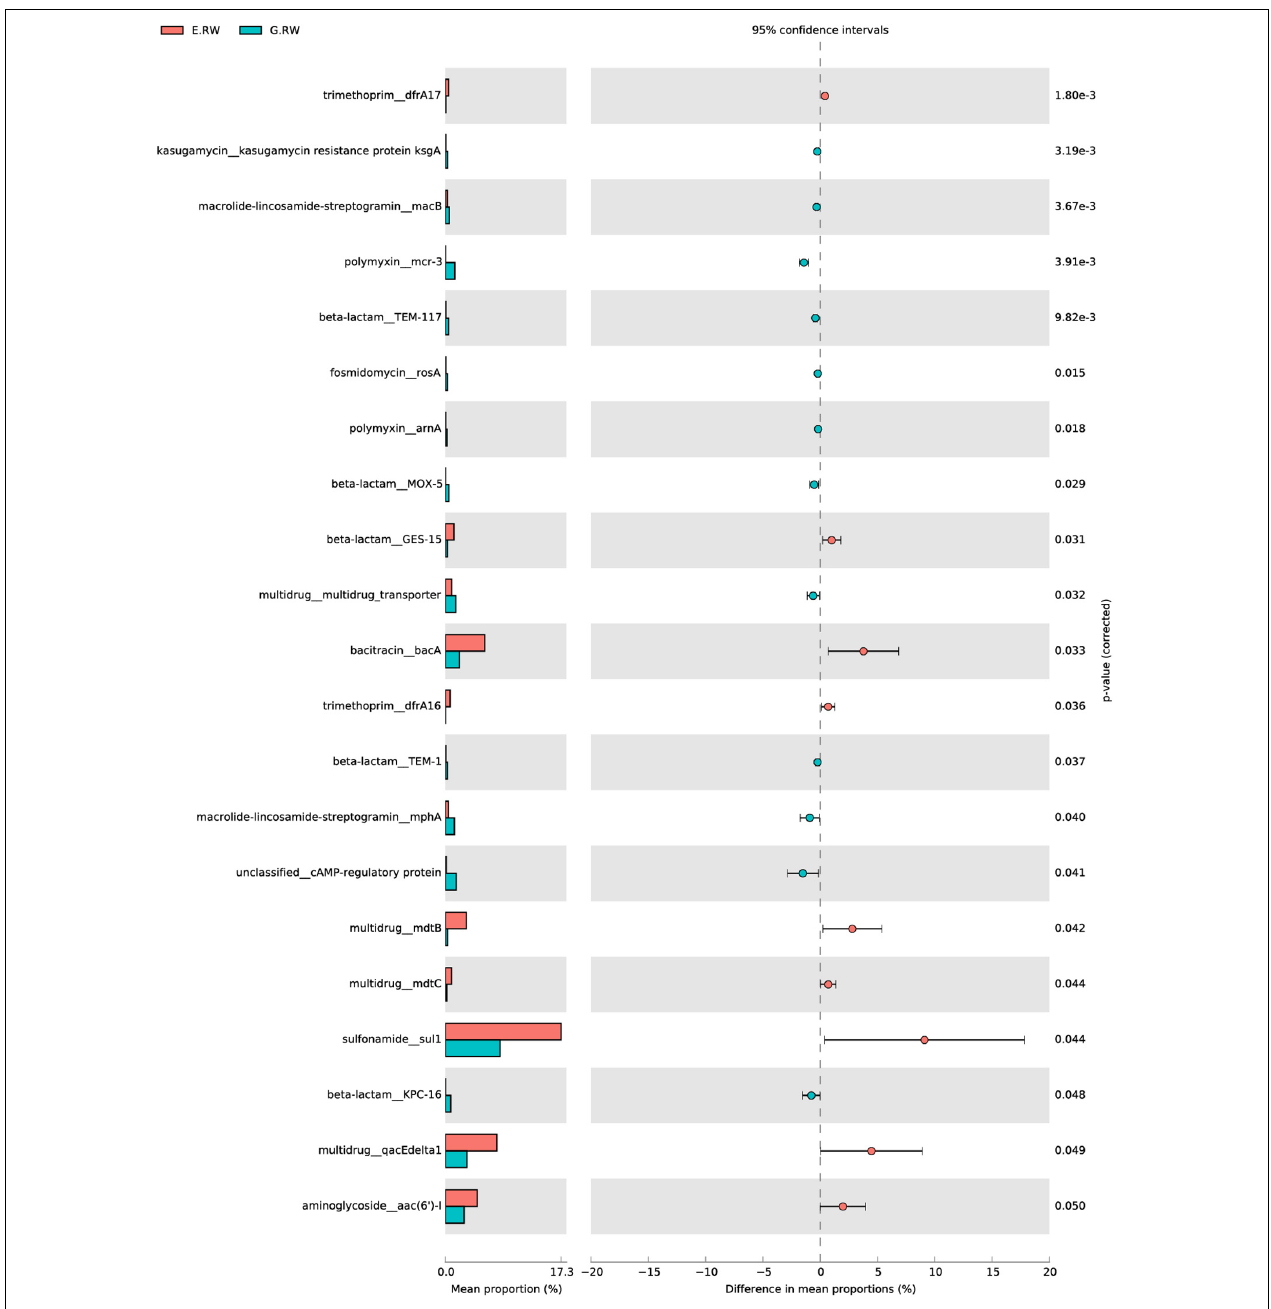
FIGURE 6 | Mean proportion and their differences for discriminative ARG subtypes between samples of E.RW and G.RW.